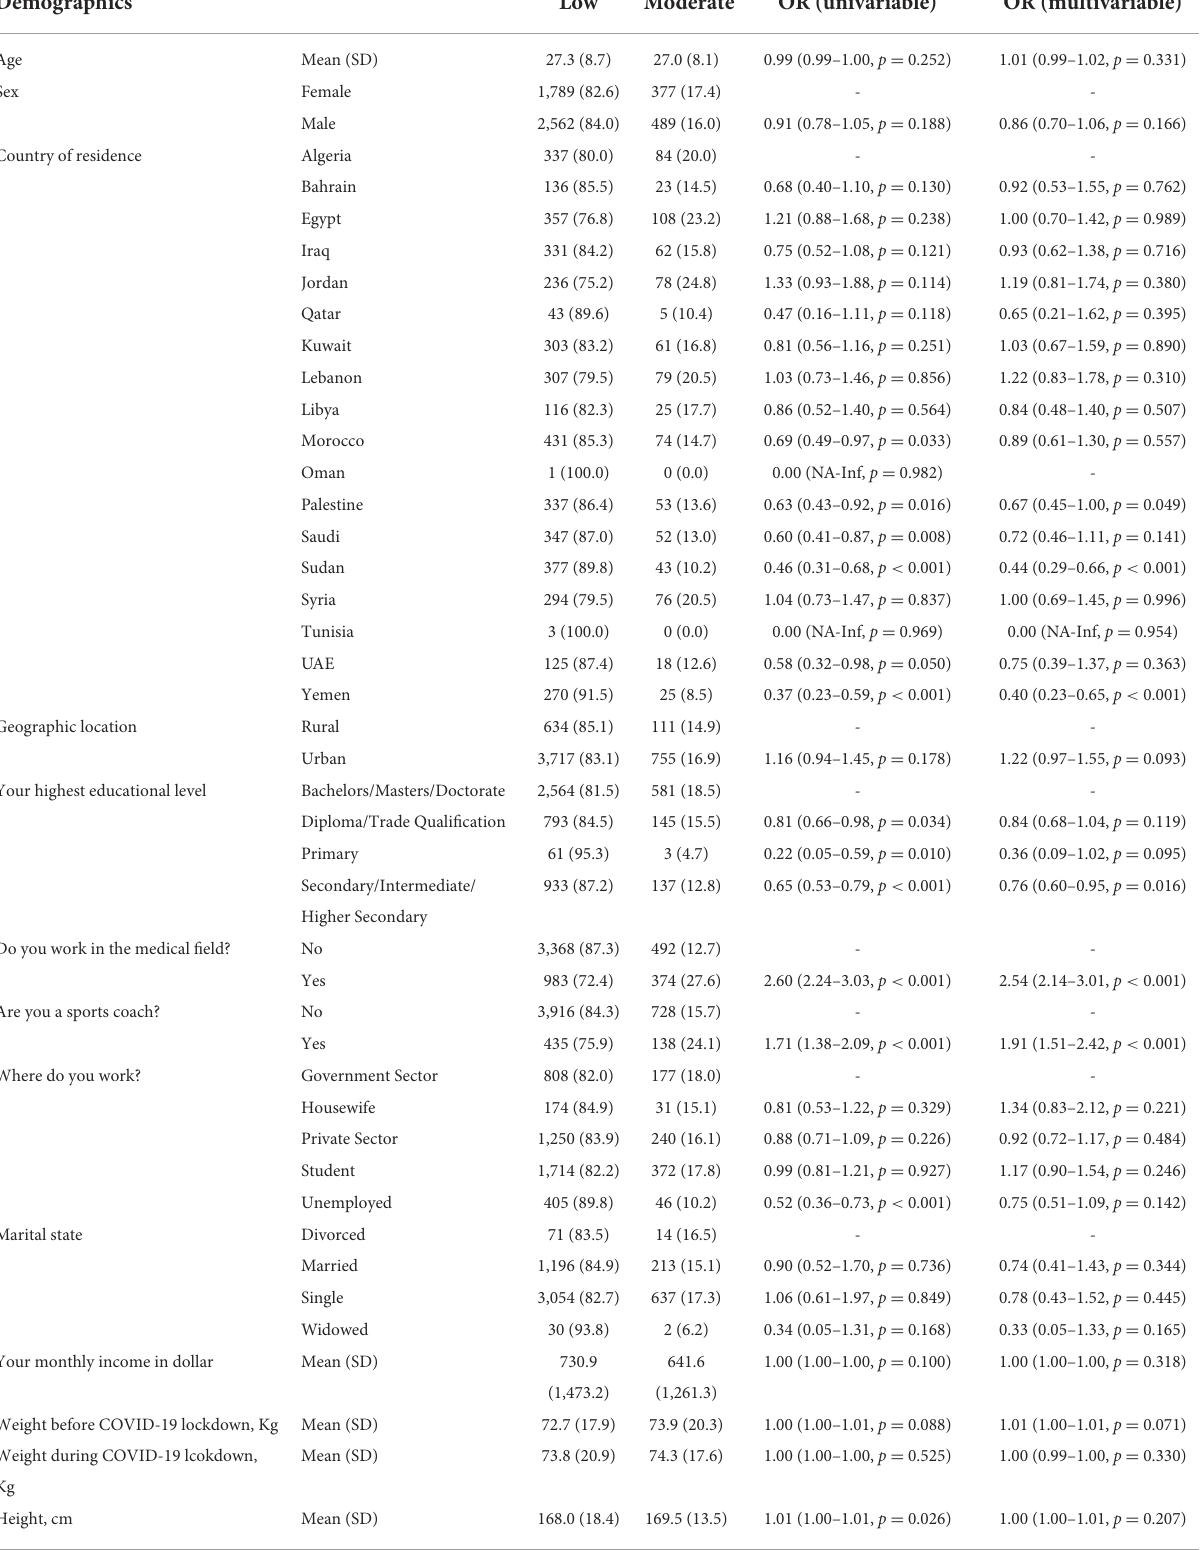
TABLE 6 Logistic regression models for the association between demographics and moderate level of